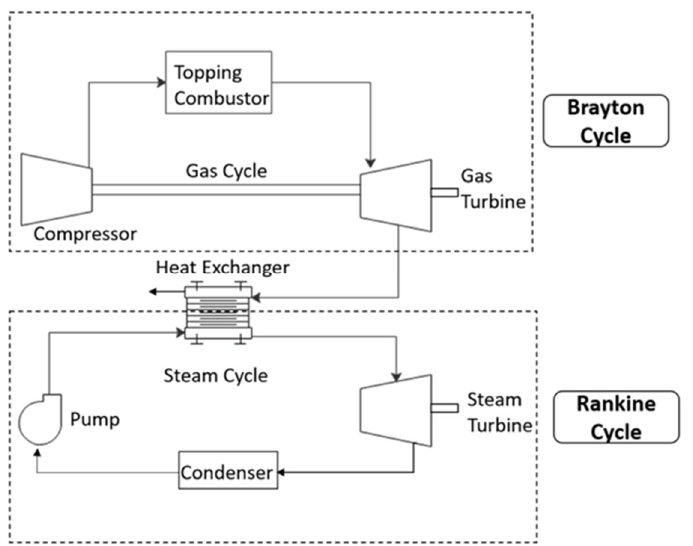
Figure 3. Scheme of a combined cycle power plant. A Brayton cycle is shown above, and the cycle below corresponds to a Rankine Cycle. below corresponds to a Rankine